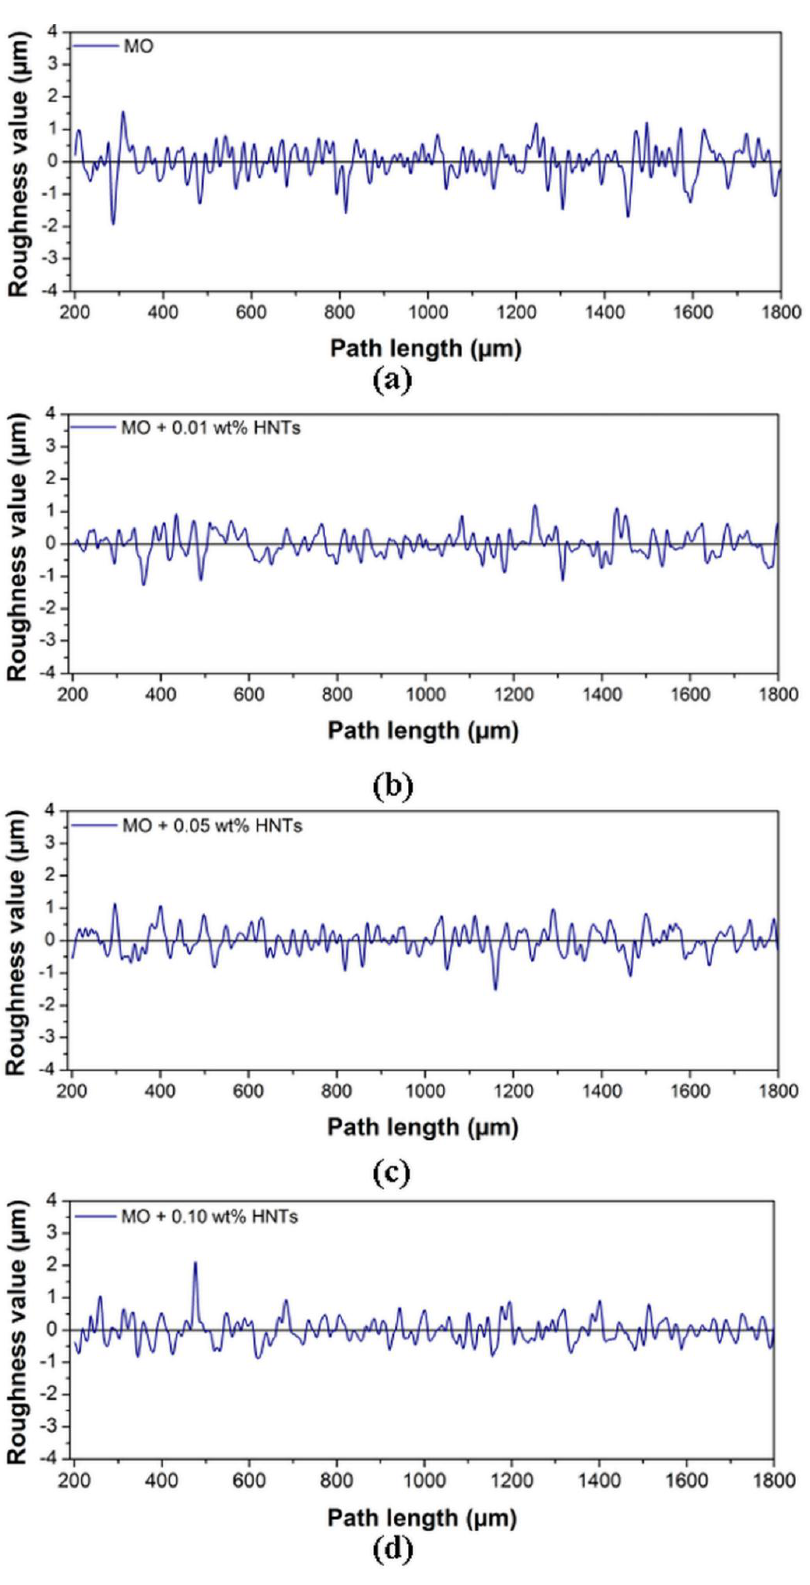
Figure 9. Roughness profiles and Ra values of worn blocks for MO + HNT nanofluidos: ( a ) MO, ( b ) MO + 0.01 wt. % HNTs, ( c ) MO + 0.05 wt. % HNTs, ( d ) MO + 0.10 wt. % HNTs.